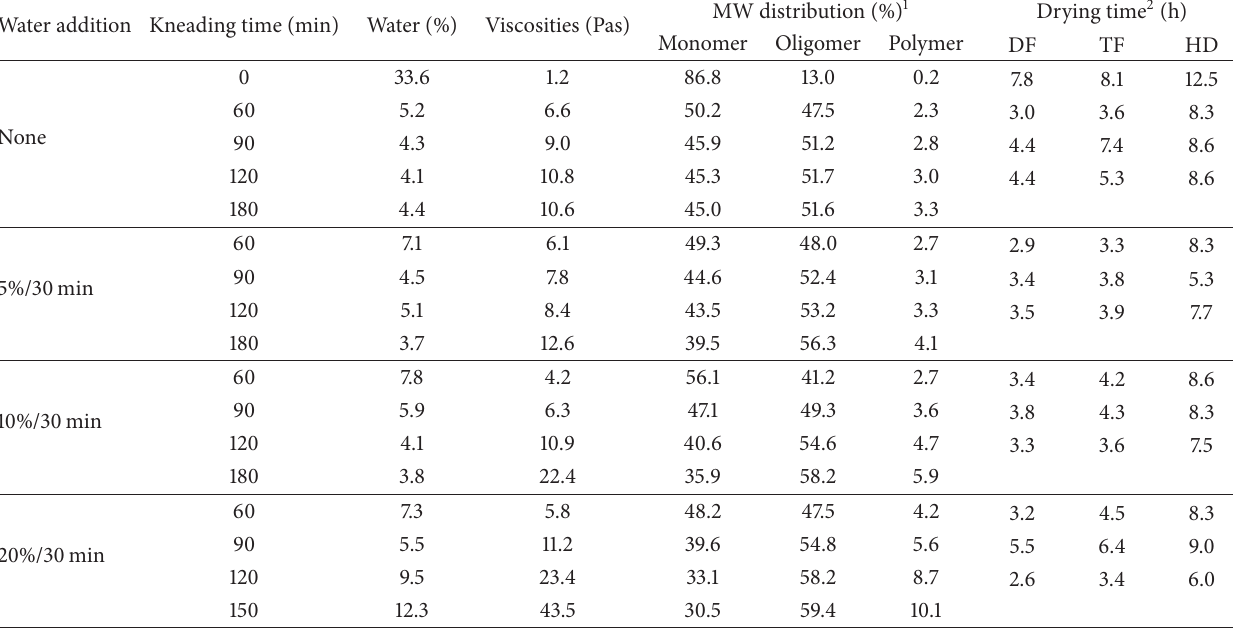
Table 7: Data results of repeated kurome